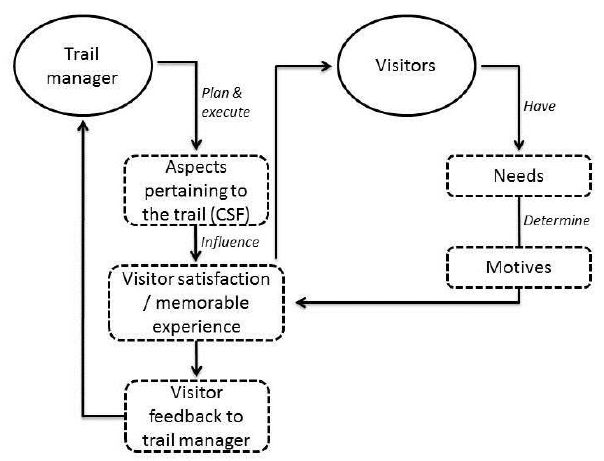
Figure 1: Relationship between motives and critical success factors for 4x4 ecotrail management Source: Own figure adapted from Williams & Saayman, 2013 and Yoon & Uysal,